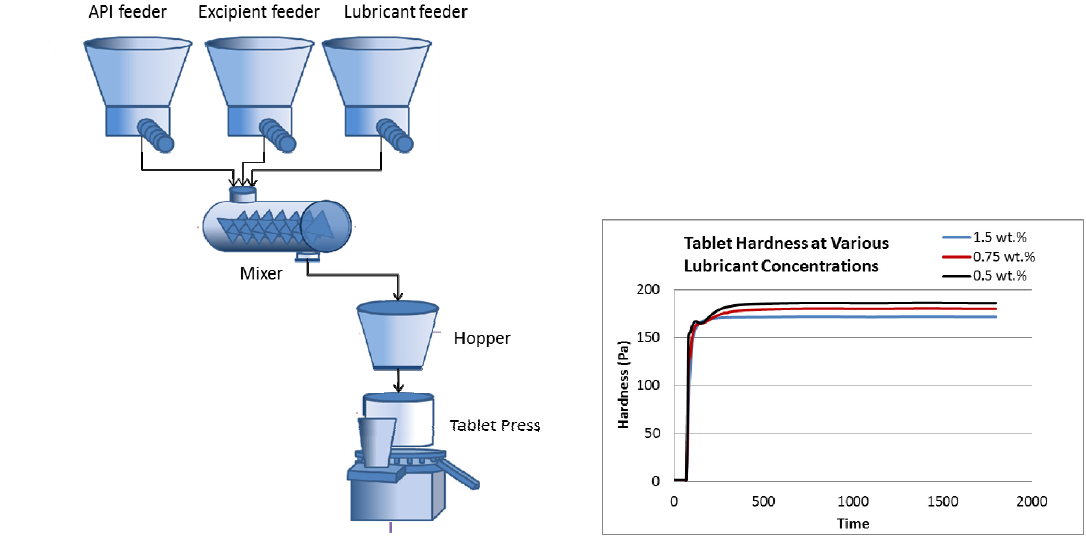
Figure 8. Direct compaction flowsheet simulated in gPROMS™ showing simulated tablet hardness as a function of lubricant